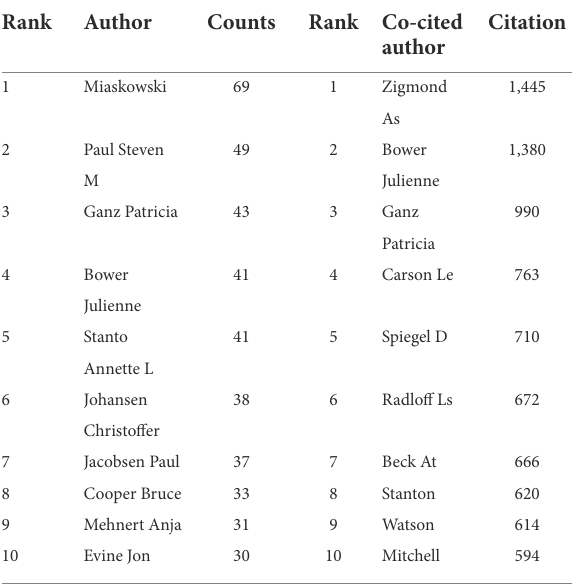
TABLE 1 Top 10 productive authors and co-cited authors in the field of depression in breast